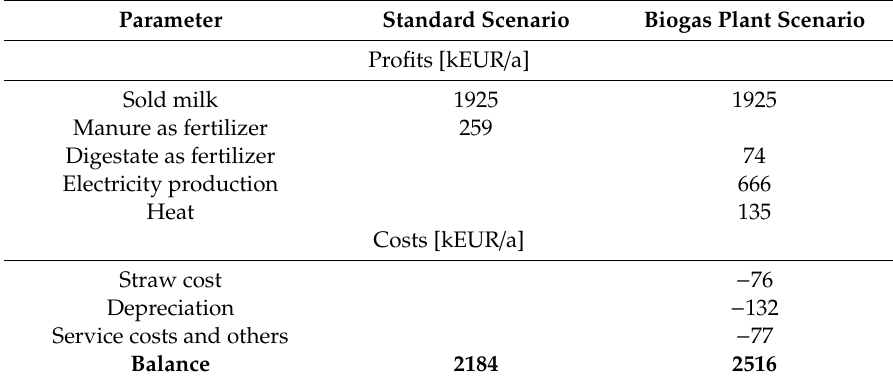
Table 4. Economic balance of the analyzed dairy farm in a conventional scenario (milk production) and in a scenario with milk production and biogas